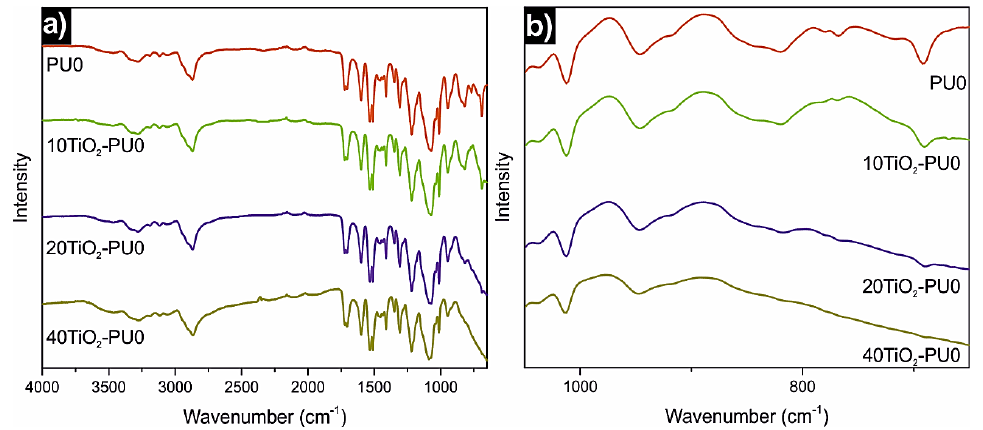
Figure 2. FTIR spectra of ( a ) the PU0 and TiO 2 -PU0 nanocomposite films and ( b ) amplification of the area around 800 cm −1 .